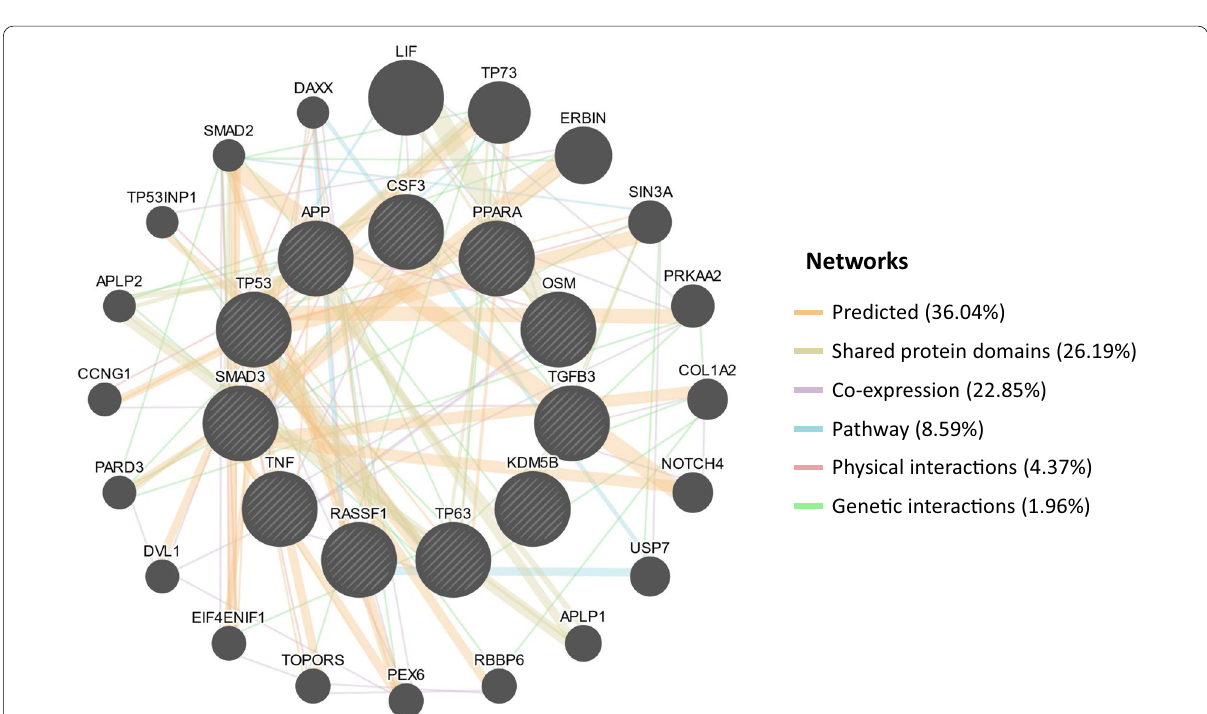
Fig. 6 Construction of a gene–gene interaction network of the upstream regulators with the most significant differential expression. Black circles with white stripes indicate genes that were entered as query terms, while black circles indicate the associated genes. The size of the circle corresponds with the number of correlations with other genes in the